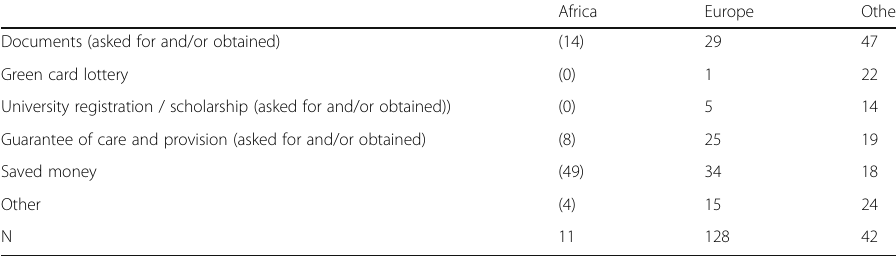
Table 5 Steps taken for emigration by would-be migrants in Dakar, by destination (1975 – 2007). %